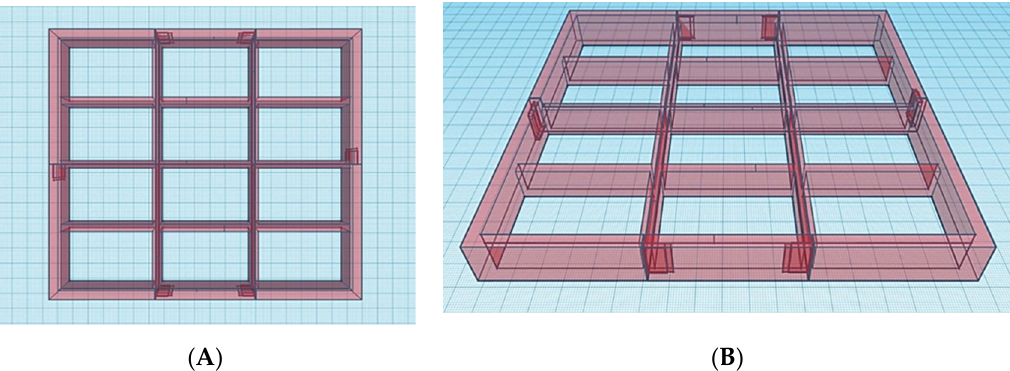
Figure 3. ( A ) Top and ( B ) front view of the CAD model designed for the resin tank insert. Each square on the blue background corresponds to a surface area of 1 cm 2 .